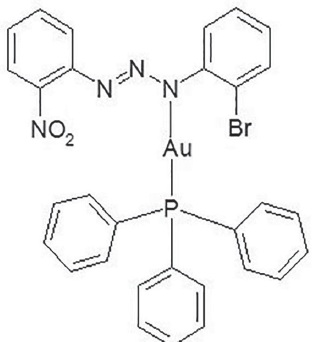
FIGURE 1 - Structure of the triazenide gold (I) complex : {[1- (2-bromophenyl) -3- (2-nitrophenyl) triazenide] (triphenylphosphine) gold